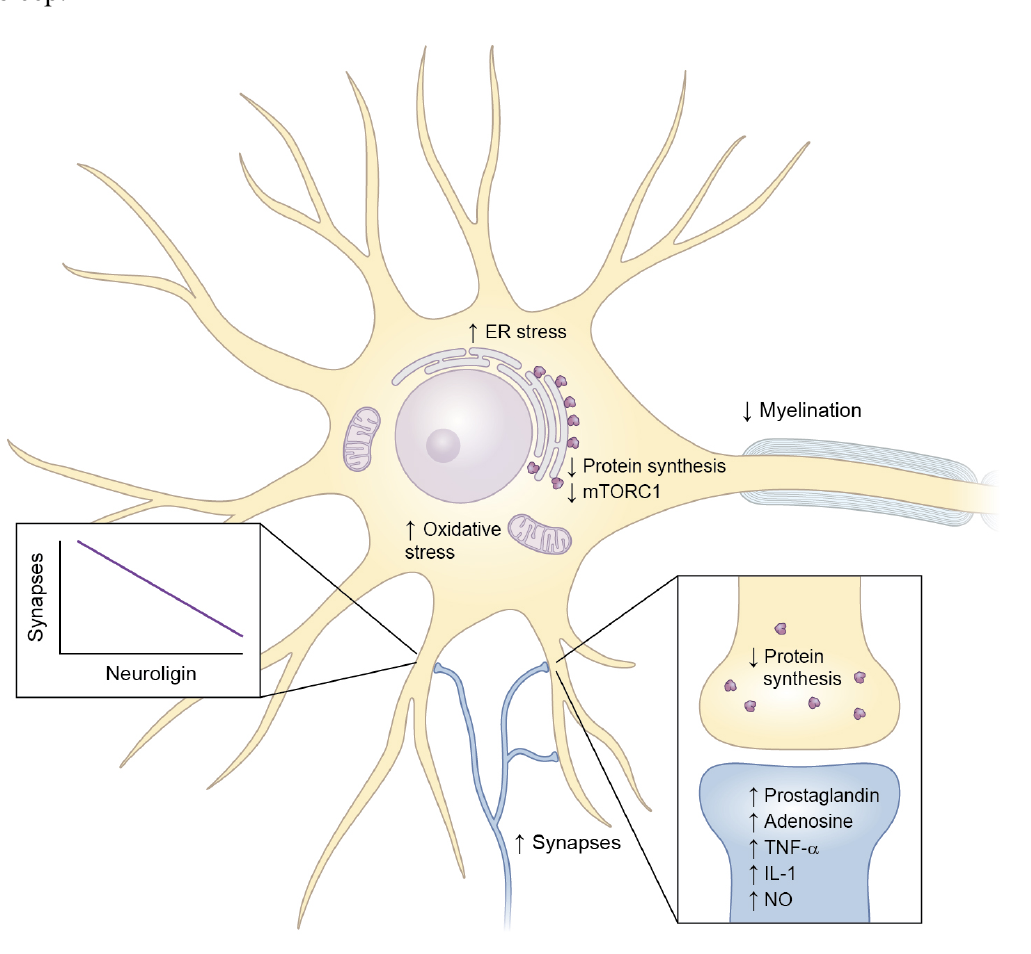
Figure 1. Hypothetical scheme illustrating cellular consequences of sleep deprivation. Prolonged wakefulness leads to the activation of cellular stress events: Endoplasmic reticulum (ER) stress and oxidative stress are activated. Myelination is downregulated. Protein synthesis (in addition to mTORC1 activity) is diminished (both globally and at synapses). Despite these changes, net synaptic upscaling occurs without proper pruning. There is also a possible relationship between the increased number of synapses and decreased neuroligin following sleep deprivation. In addition, accumulation of sleep regulatory substances in the post-synaptic terminal may lead to an increased drive for